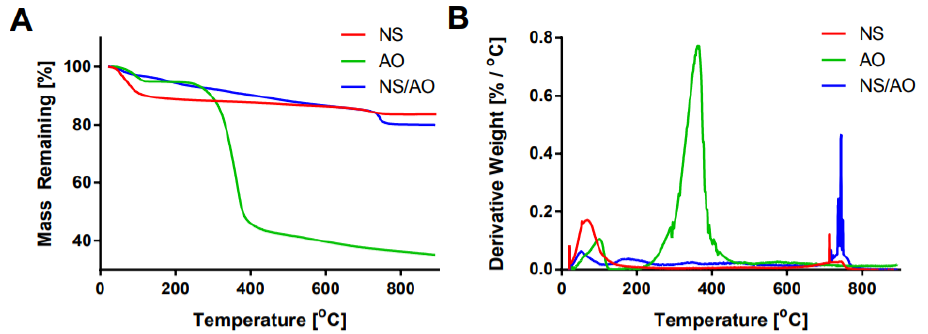
Figure 2. Thermogravimetric analysis of NS, AO, and NS/AO complexes. Percent mass remaining ( A ) and derivative weight ( B ) as a function of temperature for NS only, AO only, and NS/AO complexes reveal interaction between AO and NS particles.